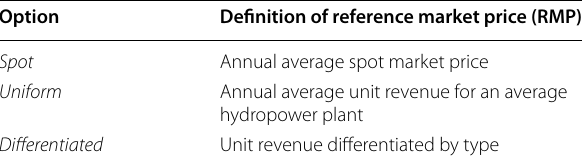
Table 4 Reference market price